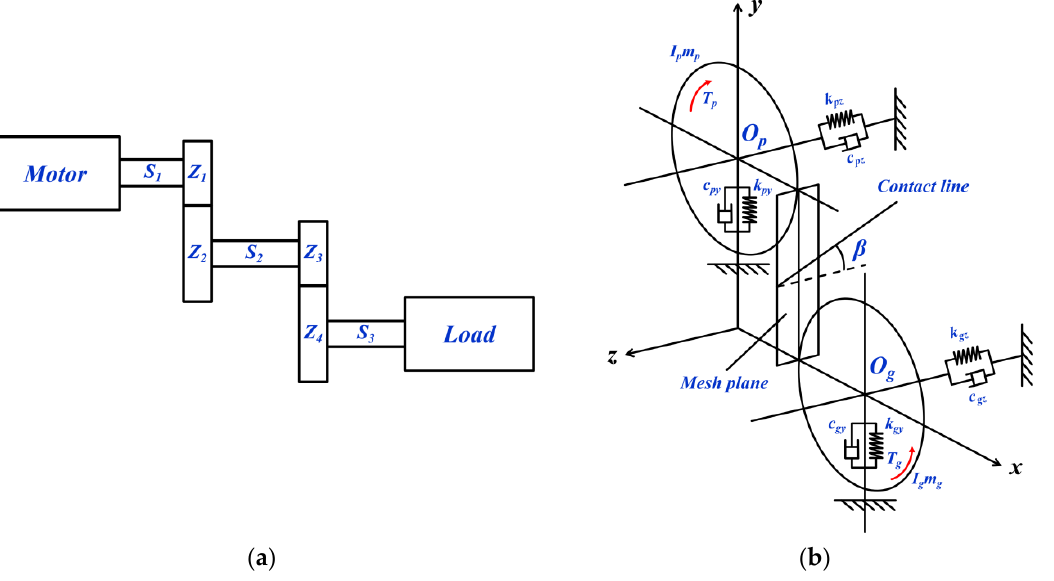
Figure 1. The dynamic model of the motor-gear system: ( a ) the layout of the motor-gear system; ( b ) the gear meshing dynamics without taking into account the frictional forces.